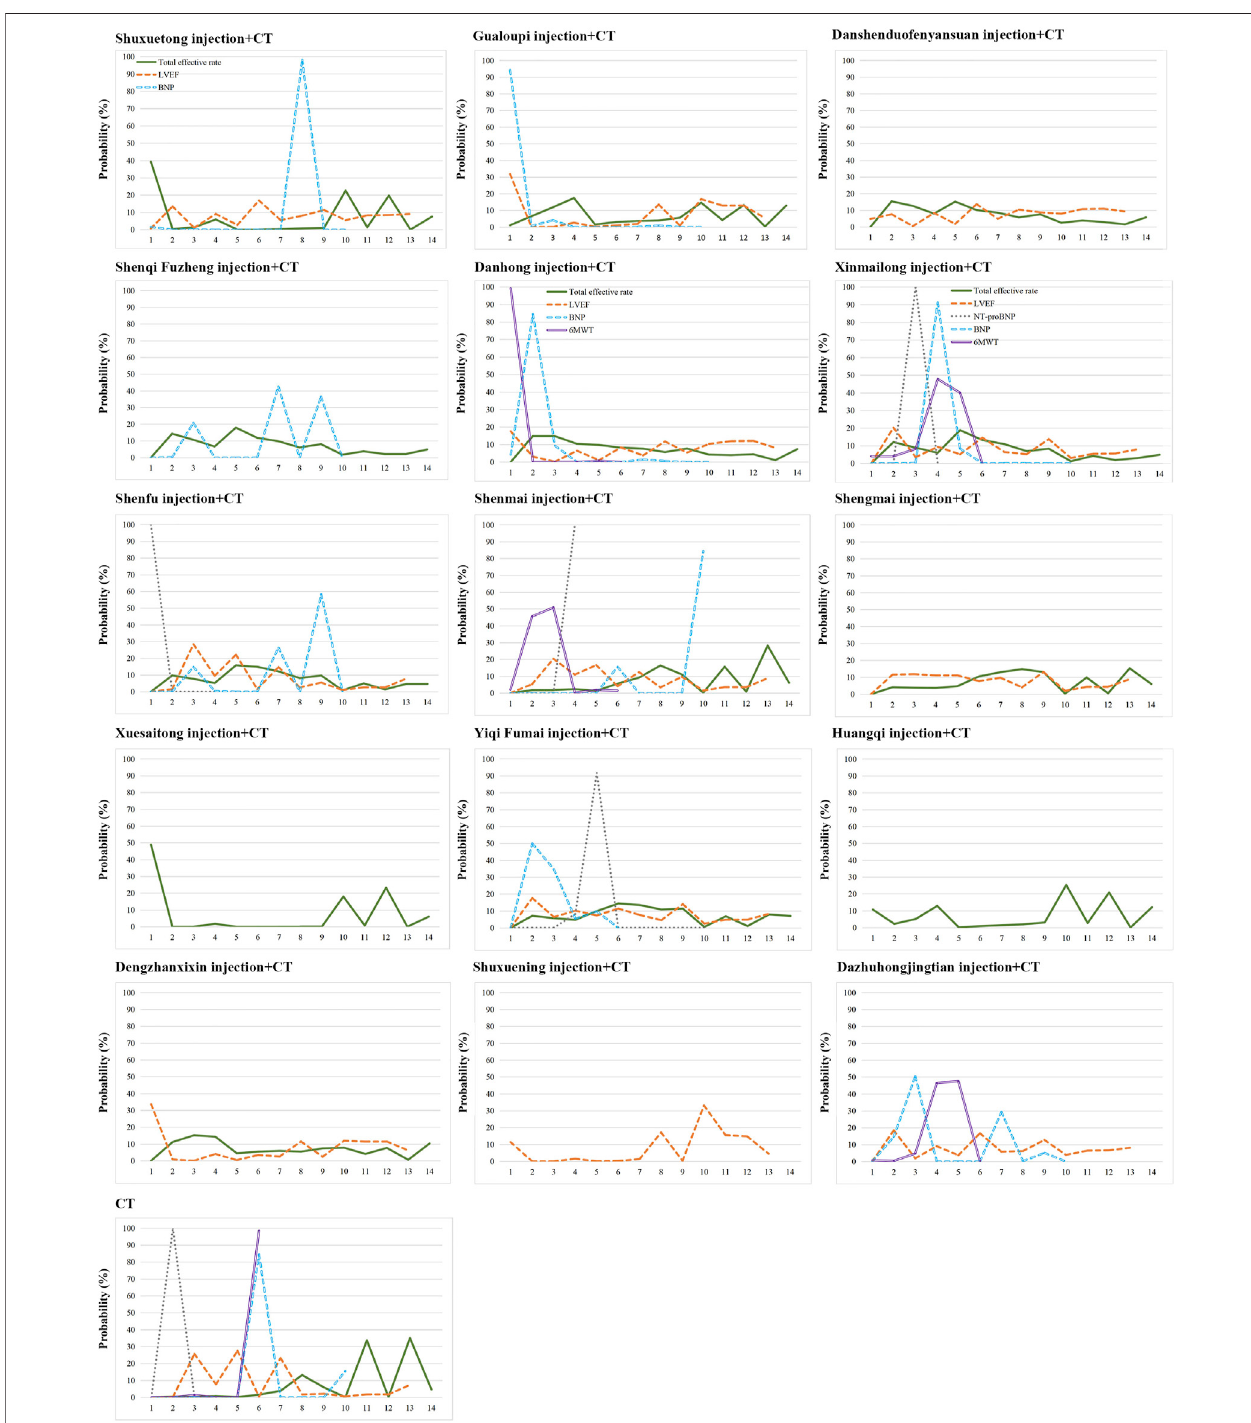
FIGURE 5 | Bayesian ranking pro fi les of comparable treatments on ef fi cacy for patients with CHD-HF.